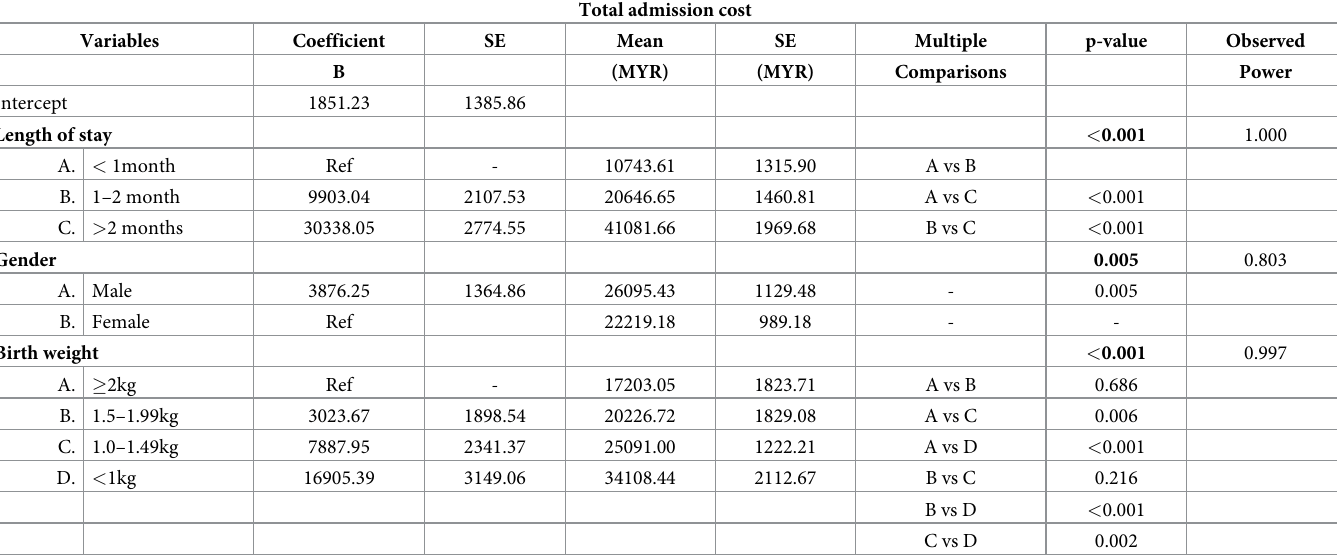
Table 4. Final variables for cost prediction (multifactorial